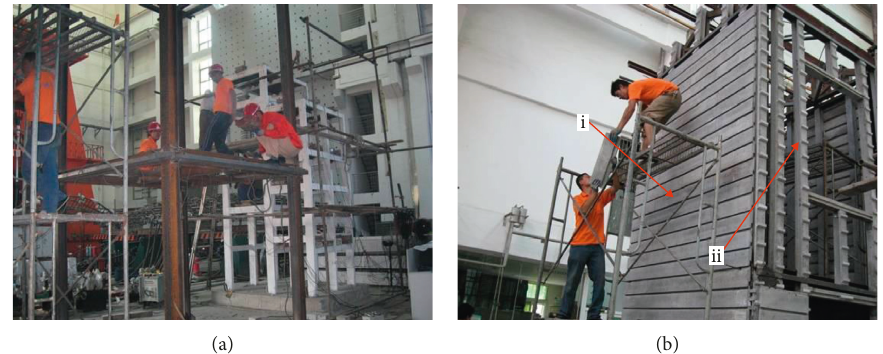
Figure 1: Prefabricated lightweight steel structure. (a) Steel frame. (b) Exterior walls: (i) prefabricated hanger slab and (ii) prefabricated hanger column.